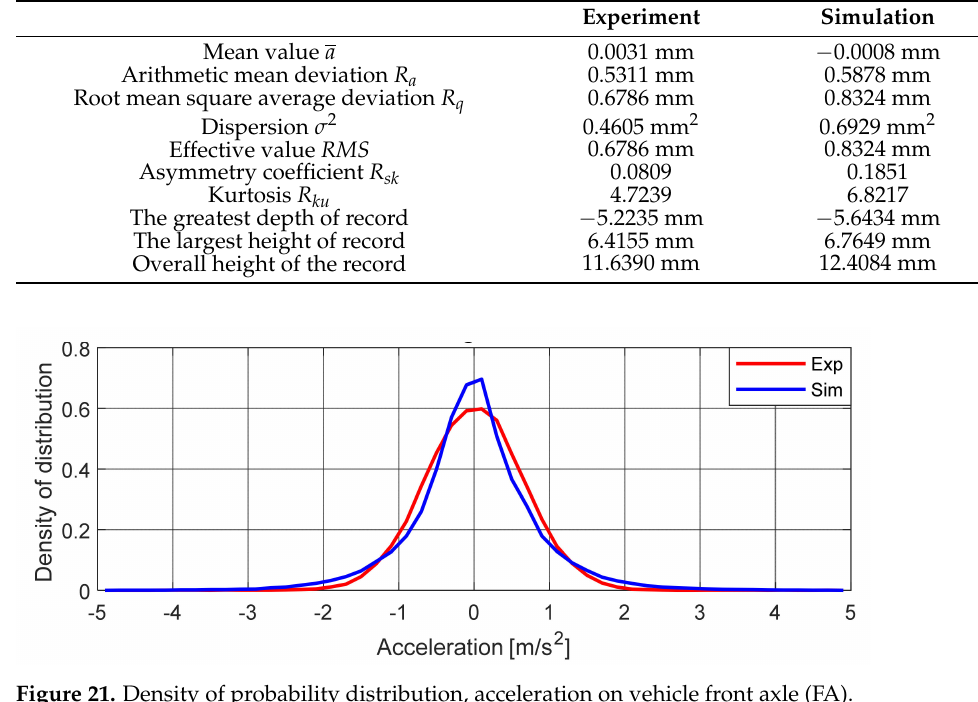
Figure 21. Density of probability distribution, acceleration on vehicle front axle (FA).